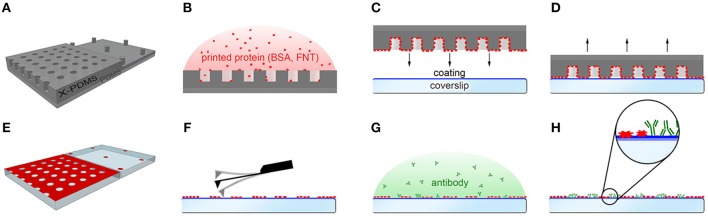
Illustration of the nanocontact printing procedure. (A) Sketch of a stamp featuring a well (left) or pillar (right) layout. (B) The protein solution is incubated on the X-PDMS/PDMS stamp. (C–E) After washing and drying, the stamp is brought into contact with a coverslip coated with MixandGo® Biosensor. The stamp is pressed onto the coverslip, incubated and removed, leaving the protein pattern on the coverslip. (F) The quality of the imprint is determined by AFM imaging. (G,H) After washing, the antibody is added to fill the interspaces, incubated and rinsed with water to remove unbound antibody.